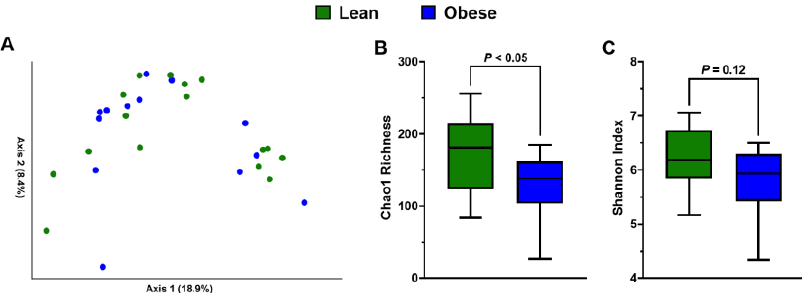
Figure 3. α - and β -Diversity measures of gut microbiota in obese and lean persons. ( A ) Principal coordinate analysis of Bray – Curtis dissimilarity of gut microbiota, ( B ) Chao1 richness estimate, and ( C ) Shannon index of obese ( n = 13) and lean ( n = 16) persons prior to the pharmacokinetics trial. Data were analyzed using QIIME2 (version 2019.10 obtained from http://qiime.org accessed 30 September 2022).